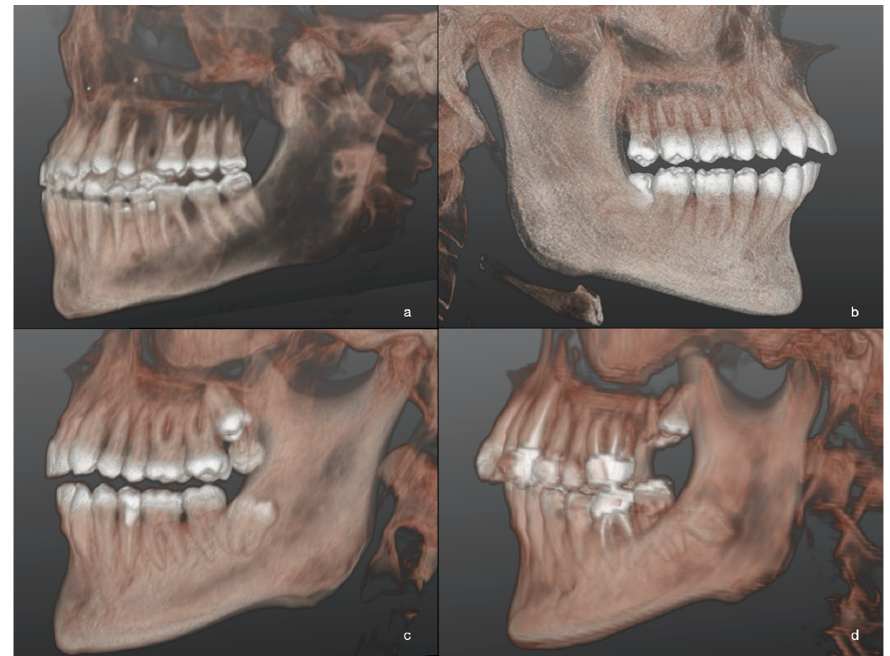
Figure 3. Three-dimensional images of M3M after 3D reconstructions of CBCT scans in patients of L-GA group. Different levels of M3M position in relation to the adjacent alveolar crest were reported: the most superficial M3M, completely erupted ( a ); partially impacted M3M in horizontal position ( b ); completely impacted M3M in the ramus with distoangular position ( c ); the deepest impacted M3M with roots closer to mandibular canal ( d ).